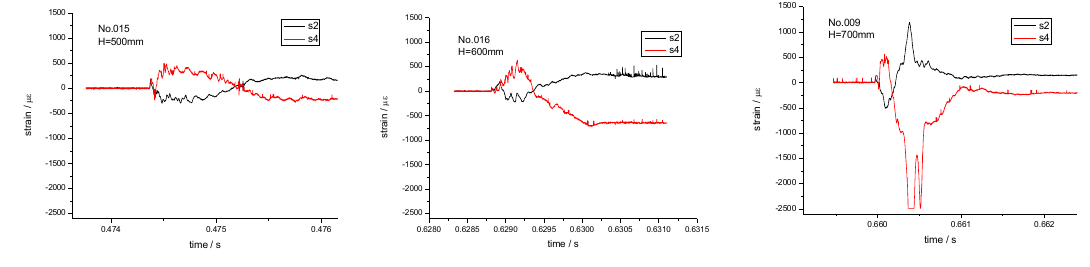
Figure 8. Strain of PBX simulation material surface during impact.